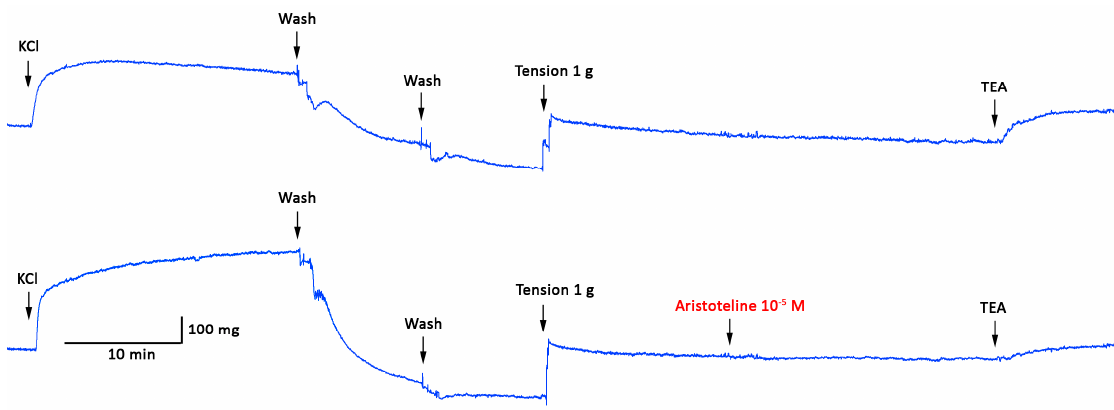
Figure 8. Original tracing showing the time course of the contractile response to KCl (60 mM) and TEA (1 mM) in intact aortic rings from rats. These are in the absence or presence of ARI (10 -5 M). The aortic rings were pre-incubated with ARI for 20 min before TEA was added.